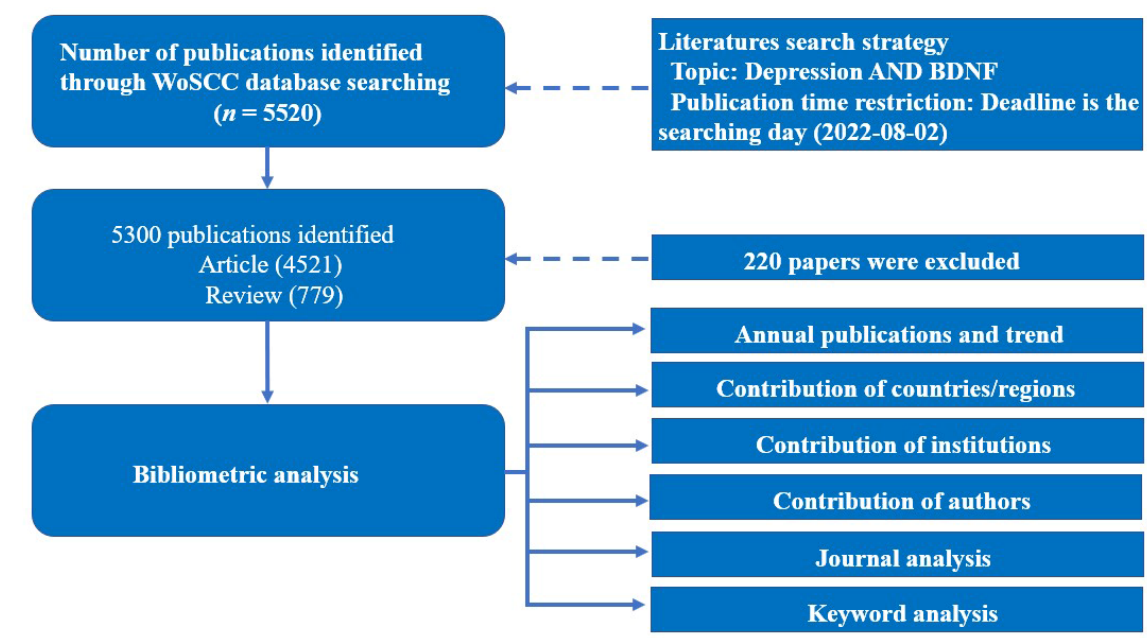
Figure 1. Flow diagram of literature identification.